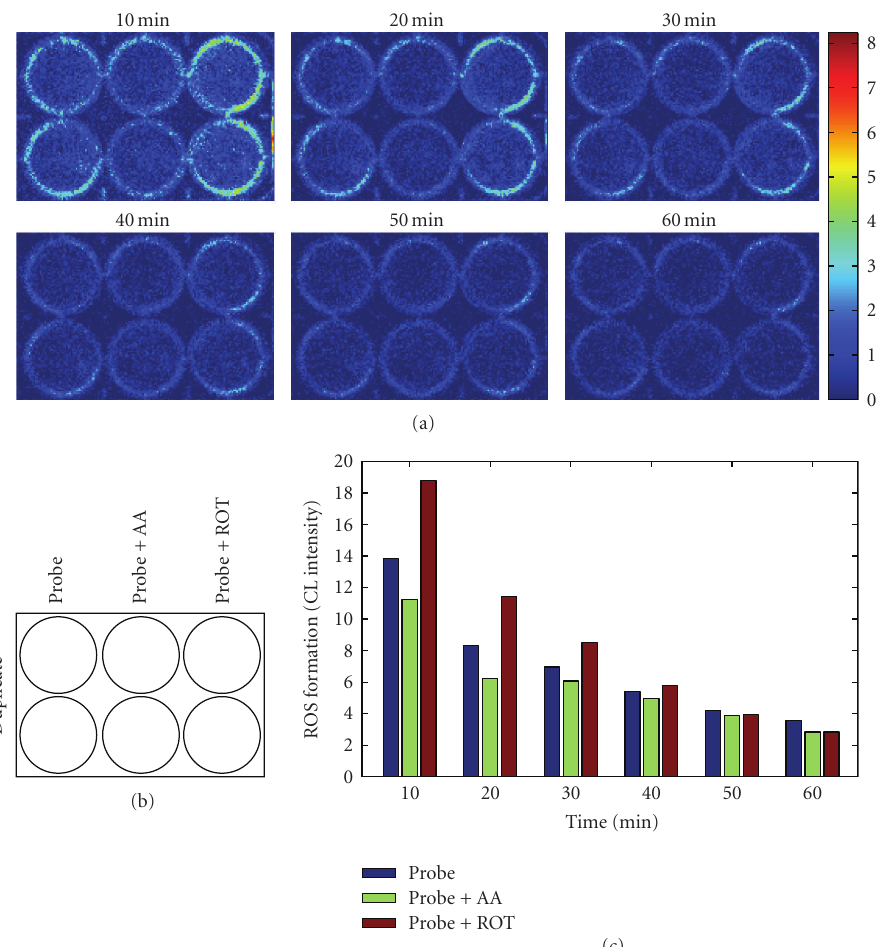
Figure 4: In situ real-time CL imaging of ROS formation in cultured H9c2 cardiomyocytes exposed to inhibitors of mitochondrial ETC. H9c2 cells were cultured in 6-well plates. Immediately prior to CL imaging, confluent cells in culture were washed once with PBS followed by addition of 2 mL PBS containing 10 μ M AA or ROT in the presence of probe (luminol/HRP), as described under Materials and Methods section. (a) Representative CL images acquired at the indicated time points; (b) layout of treatment groups, probe refers to